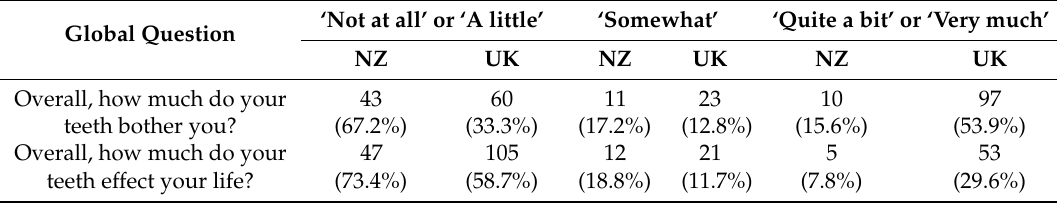
Table 2. Responses of the NZ participants (n = 64) and UK participants (n = 184) to the two global